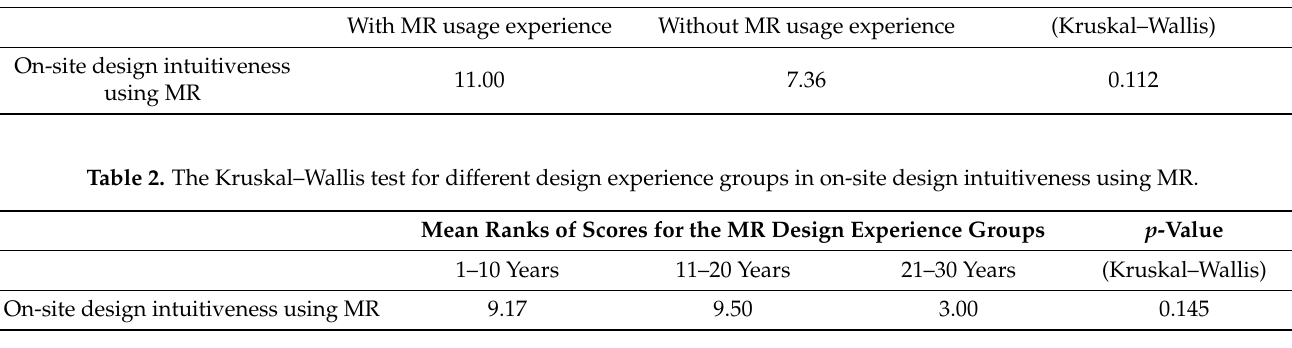
Table 1. The Kruskal–Wallis test for different MR usage experience groups in on-site design intuitiveness using MR. Mean Ranks of Scores for the MR Usage Experience Groups p -Value With MR usage experience On-site design intuitiveness using MR